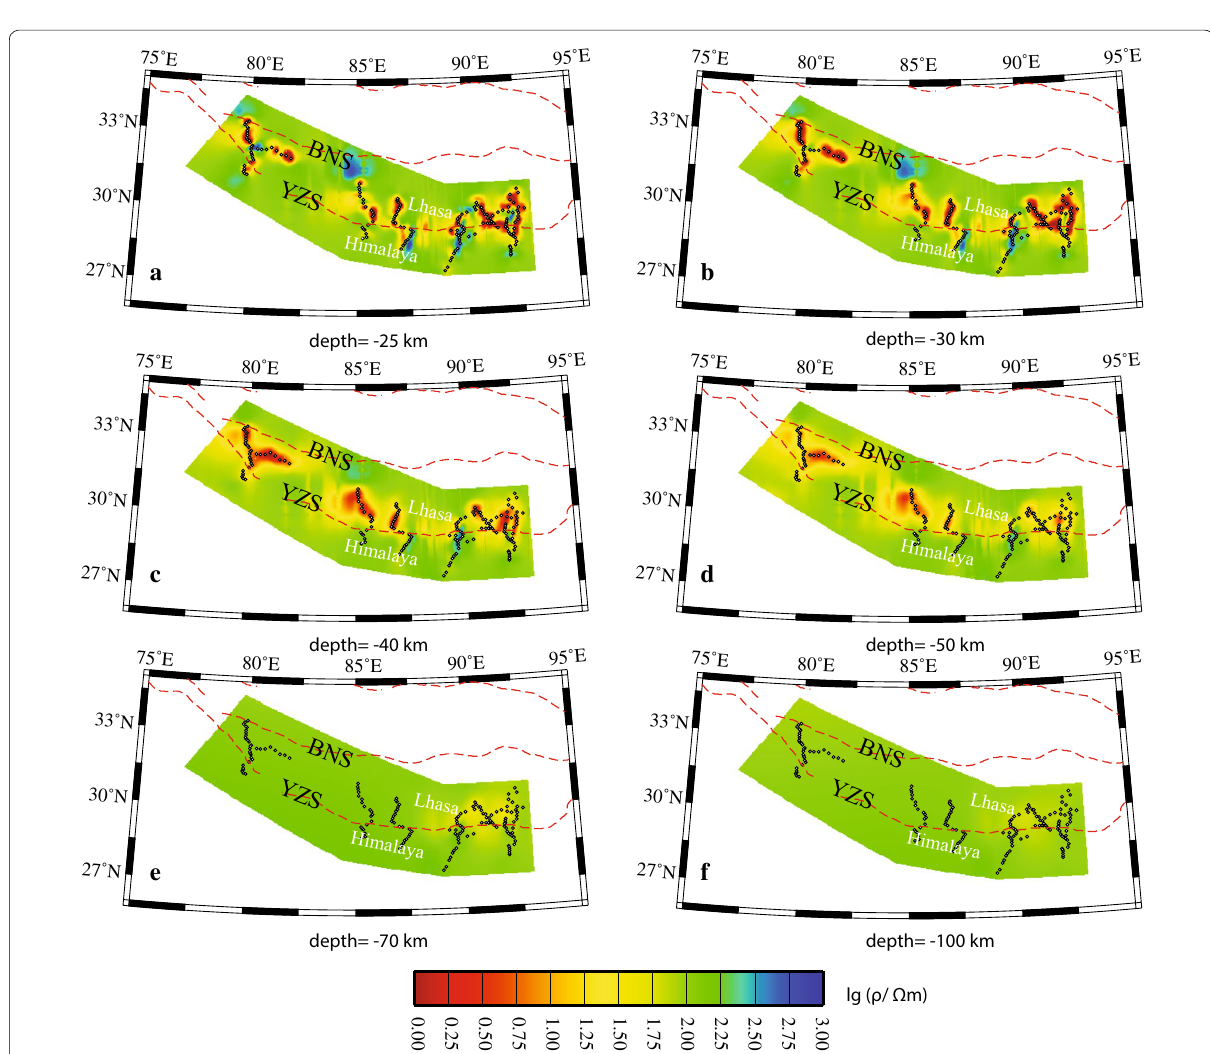
Fig. 7 Horizontal slices of the electrical model from shown in red while the high resistivity areas are shown in blue. Panels a to f are for depths